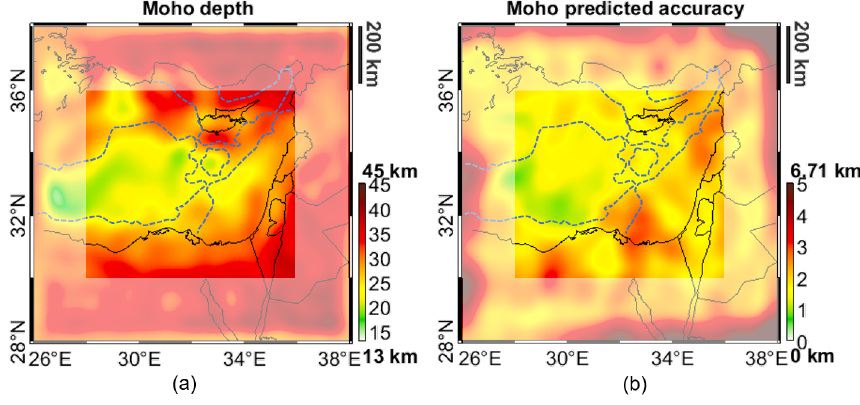
Figure 9. The estimated Moho depths ( a ) and its accuracy in terms of standard deviation ( b ). Transparent regions identify the 2 ◦ border areas, dashed blue lines represent the boundary of the main geological